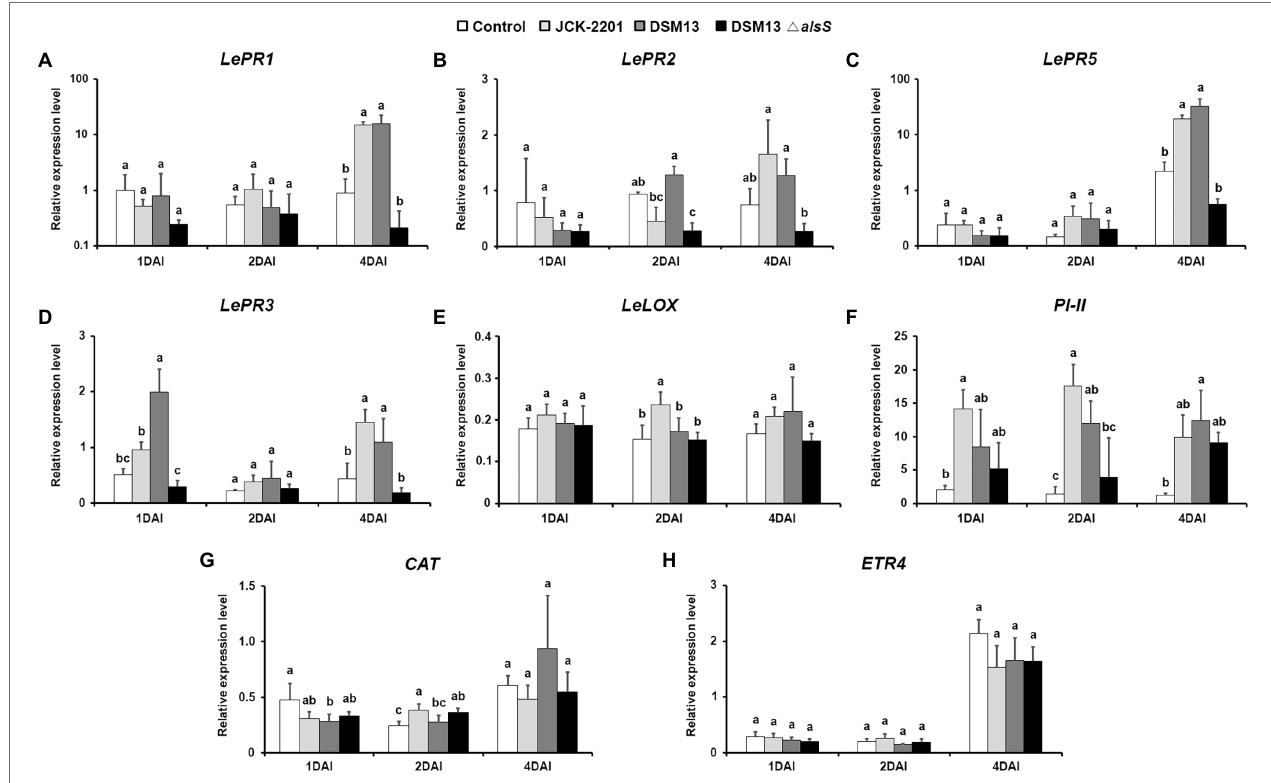
FIGURE 6 | Induction of tomato defense-related gene expression by culture supernatant of K. pneumoniae JCK-2201, B. licheniformis DSM13, and B. licheniformis DSM13 Δ alsS at 1, 2, 4 days after inoculation. Expression of defense genes of the SA signaling pathway-related genes (A) LePR1 , (B) LePR2 , and (C) LePR5 , JA signaling pathway-related genes (D) LePR3 , (E) LeLOX , (F) PI-II , ROS-related gene (G) CAT , and ET signaling pathway-related gene (H) ETR4 in tomato plants were quantified. The housekeeping gene LeUBI was used for normalization. The data show the means ± SD ( n = 3). Lower-case letters indicate statistically significant differences as compared to untreated control plants ( p < 0.05) according to Tukey’s HSD test. Error bars indicate the